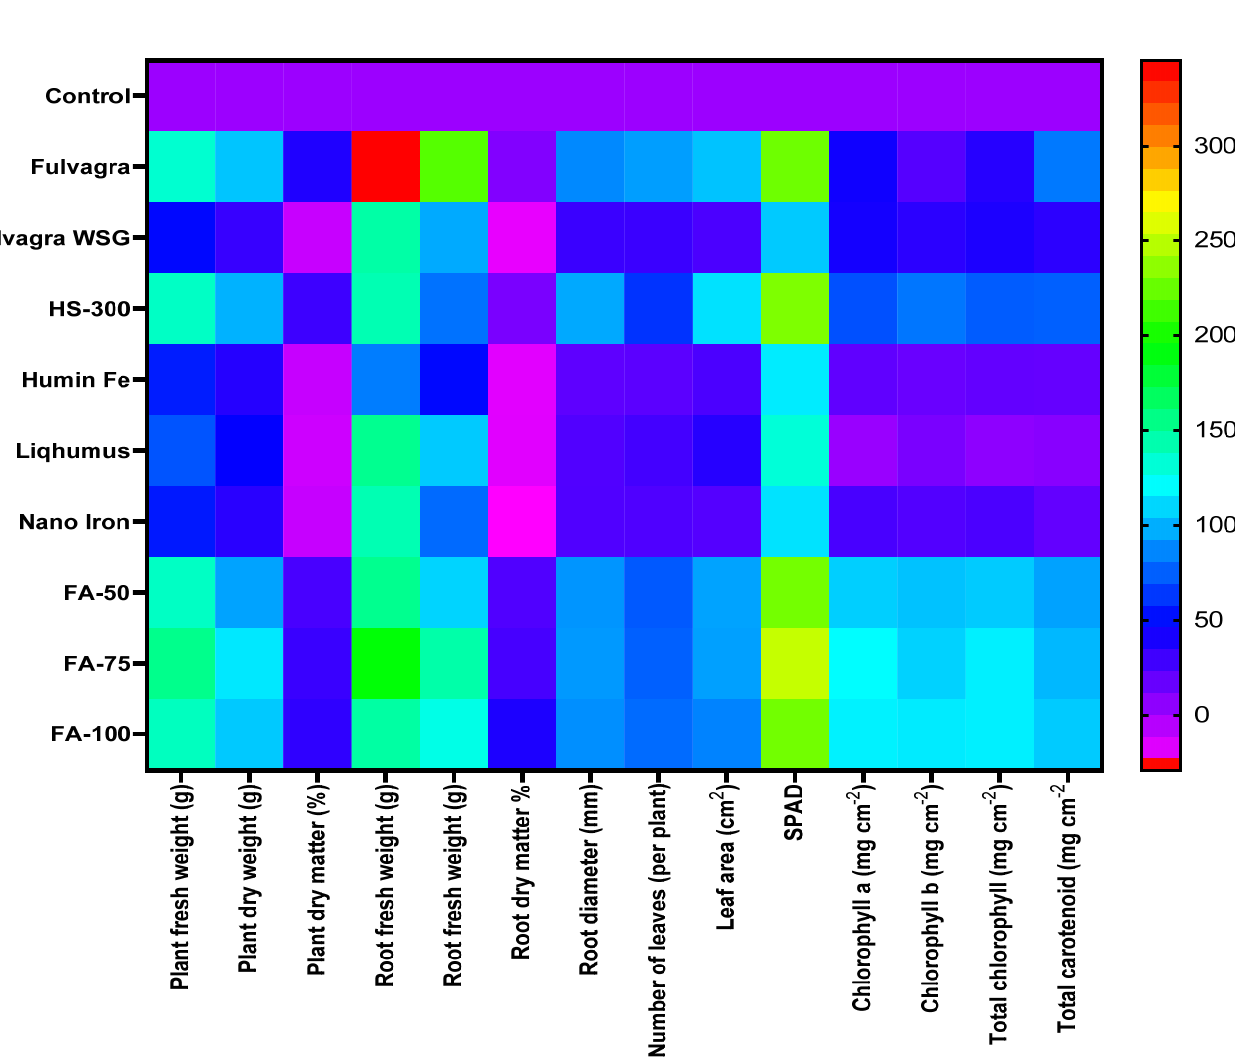
Table 3. Effects of different treatments on leaf and root macro- and micro-nutrient content.